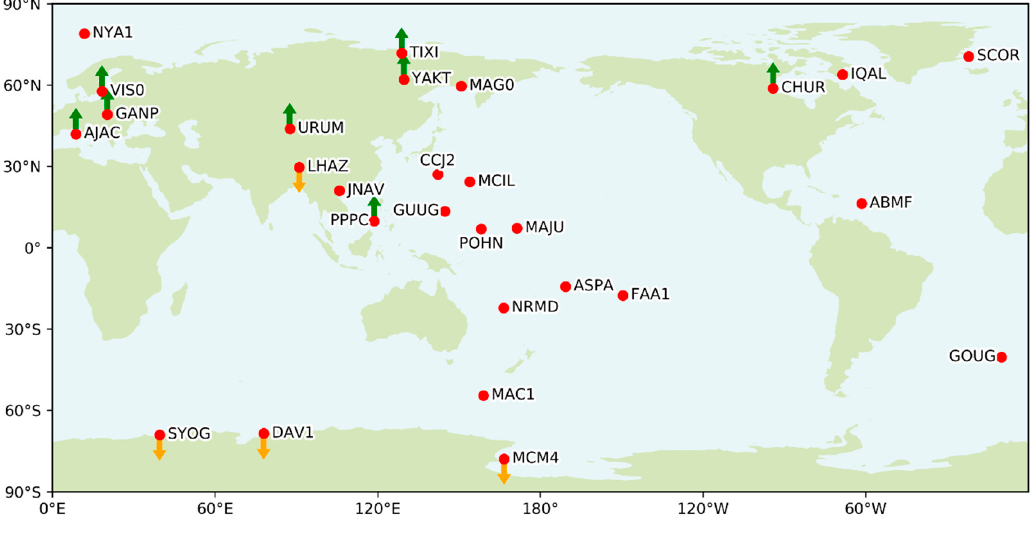
Figure 5. Seasonal biases examples for GANP station (Ganovce, Slovakia, altitude 703 m), LHAZ station (Lhasa, China, altitude 3650 m), URUM station (Urumqi, China, altitude 919 m), and YAKT station (Yakutsk, Russian, altitude 98 m). The series of differences were calculated at ground + 1000 m altitude, with the exception of the LHAZ station (ground level).